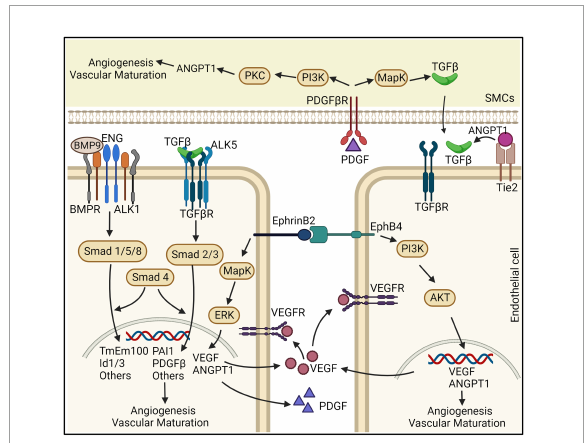
FIGURE2 Schematic representation of the effects ECs and vSMCs on bAVM development. ENG and ALK1 are receptors of BMPs. TGF- β interacts with ALK5 and TGF- β R that are predominantly expressed in ECs. BMP9/10-ENG-ALK1 by triggering SMAD1,5,8, and 4 regulate angiogenesis and vascular maturation. Disruption of this pathway can cause the development of bAVMs. ANGPT/Tie2 are linked to TGF- β activation and binding to TGF- β R, which through SMAD2,3, and 4 induces angiogenesis. EphrinB2/EphrinB4 are differentially expressed in arterial and venous ECs. PDGFB and PDGFR- β both have an essential role in pericyte recruitment during angiogenesis. In the vSMCs, PDGFB upregulates ANGPT-1 through PI3K and PKC pathway and upregulates TGF- β 1 expression through the MAPK pathway. ANGPT-1: angiopoietin 1, PDGFB: platelet derived growth factor B, PDGFR- β : PDGF receptor β , ECs: endothelial cells, SMCs: smooth muscle